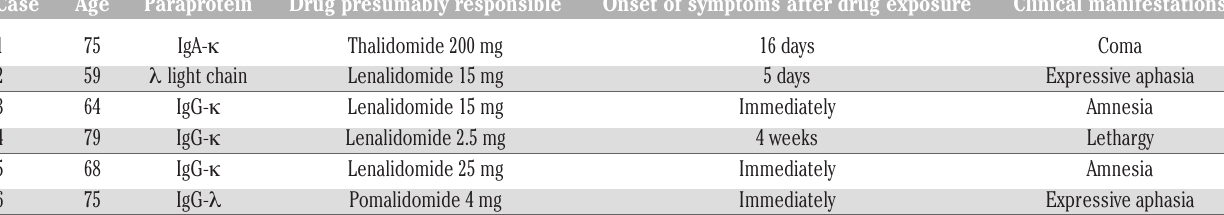
Table 1. Patients’